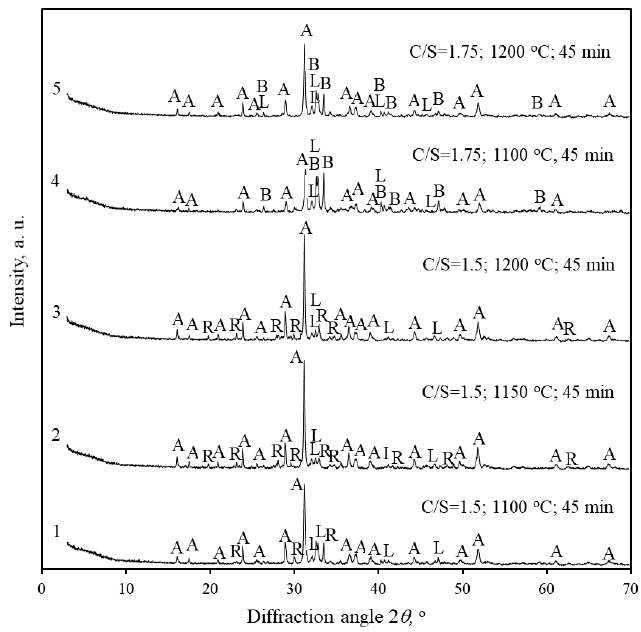
Figure 7. XRD patterns of Karpenai limestone—Saltiskiai clay mixtures fired at different temperatures. Indexes: A—akermanite, B—bredigite, R—rankinite, L—larnite.